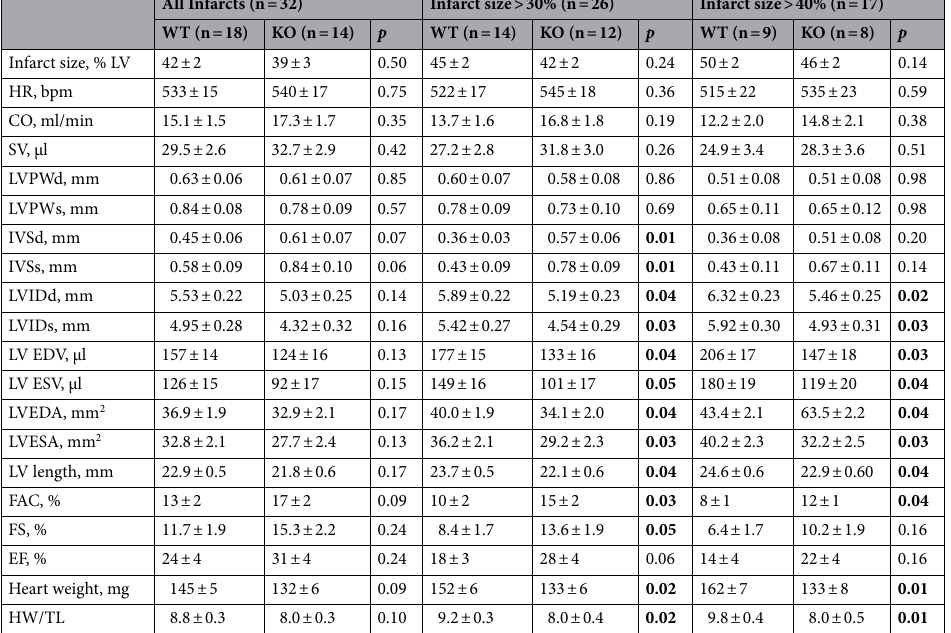
Table 1. Hemodynamic data and heart weight in WT and IL-1α KO mice 6 weeks after MI. Data from all animals and data form animals with infarct size > 30% and > 40% LV. P values calculated by t test (two group comparisons). Values in bold indicate significant differences between WT and KO mice. BPM beats per minute, CO cardiac output, FAC fractional area change, FS fractional shortening, EF ejection fraction, HR heart rate, HW/TL heart weight/tibia length, IVSd interventricular septum thickness, diastole, IVSs interventricular septum thickness, systole, LV left ventricle, LVEDA LV end diastolic area, LVESA LV end systolic area, LV EDV LV end diastolic volume, LV ESV LV end systolic volume, LVIDd LV inner diameter, diastole, LVIDs LV inner diameter, systole, LVPWd LV posterior wall thickness, diastole, LVPWs LV posterior wall thickness, systole, SV stroke